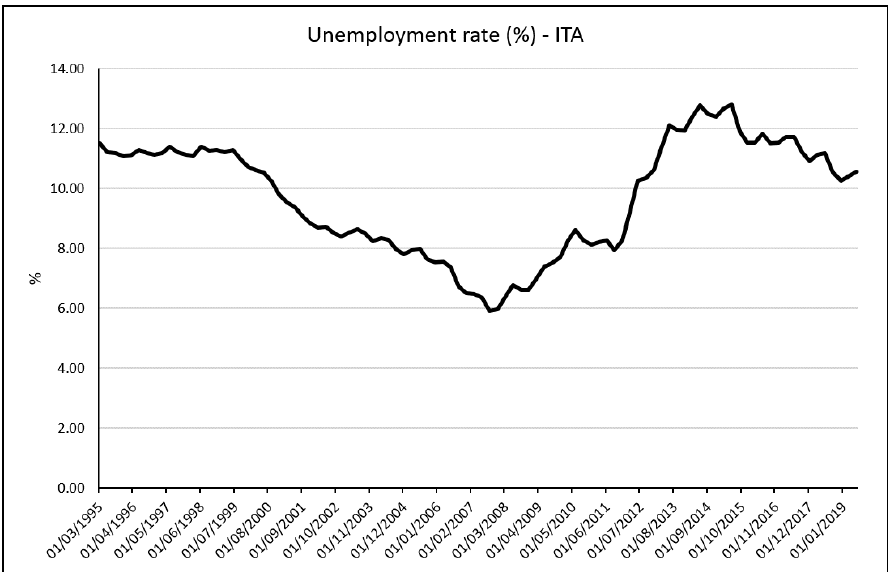
Figure 1. Italian Inflation rate from the period of 1995:Q1 to 2019:Q2 (data source: Eurostat, 2019, ‘own